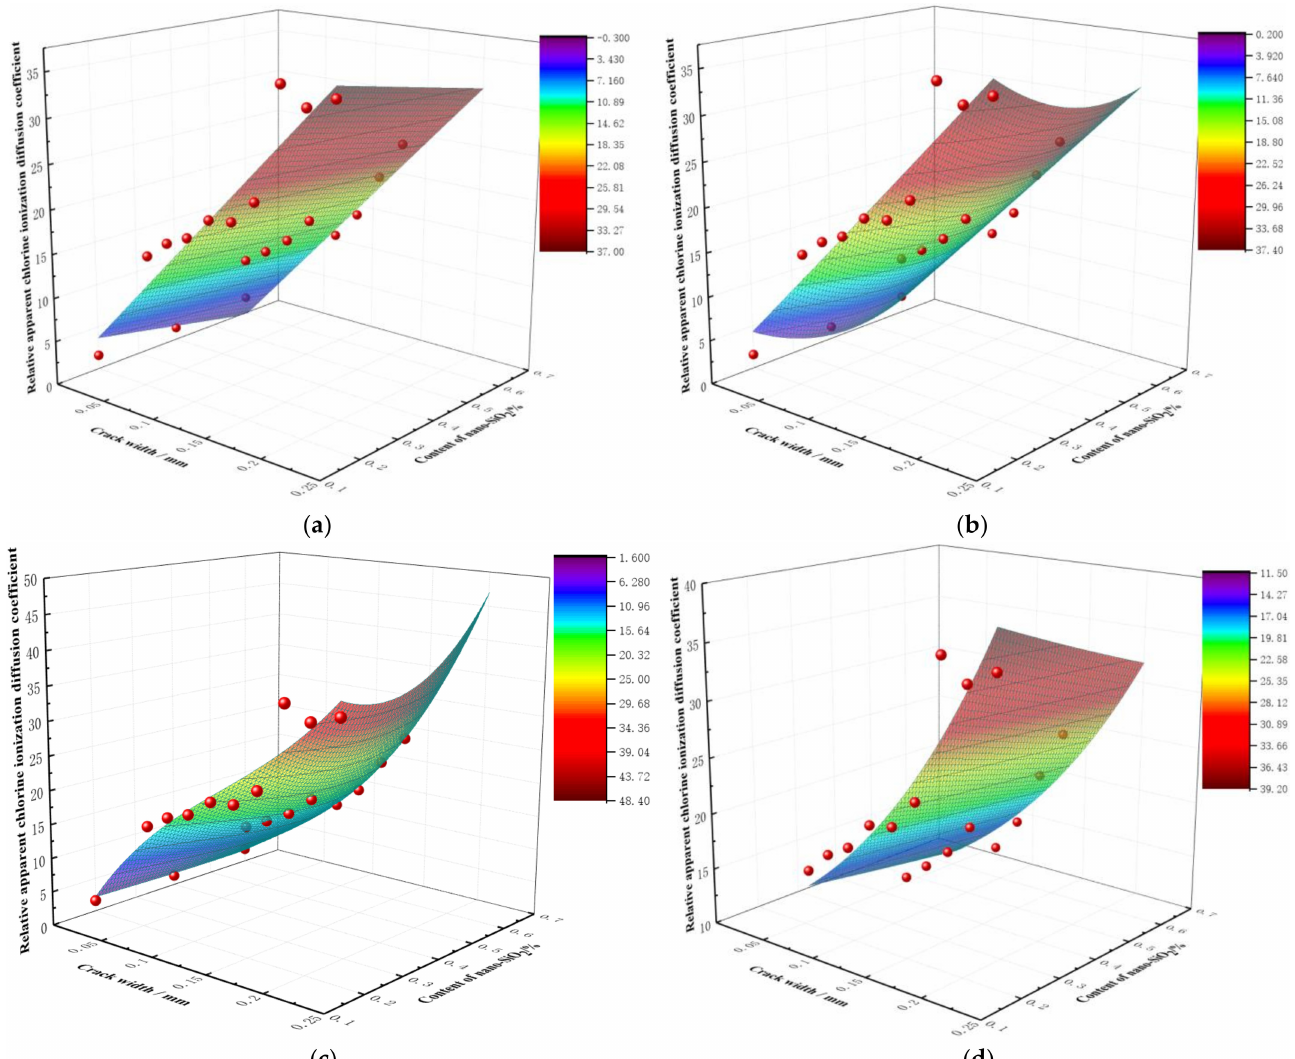
Figure 17. Fitting results of first power function ( a ), second power function ( b ), third power function ( c ) and exponential function ( d